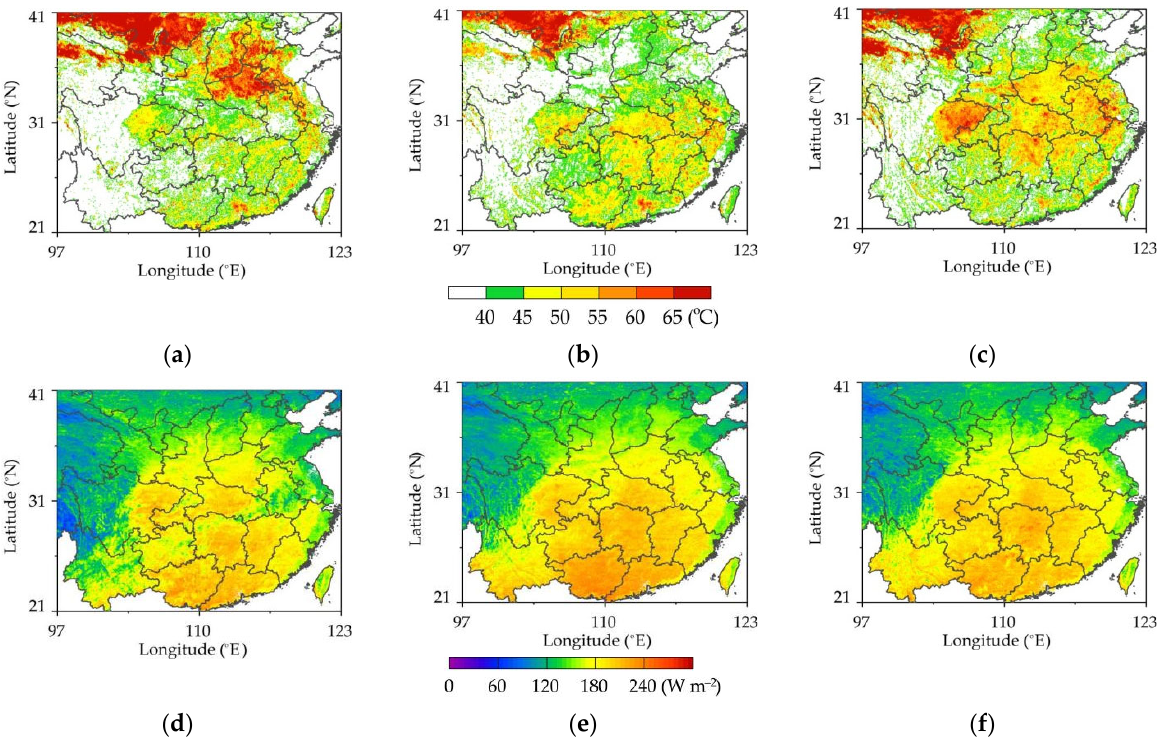
Figure 13. Distributions of LST and ET in the summer of 2022, where ( a – c ) are the distributions of LST in late June, late July, and middle August, respectively, and ( d – f ) are the distributions of ET in late June, late July, and middle August, respectively.